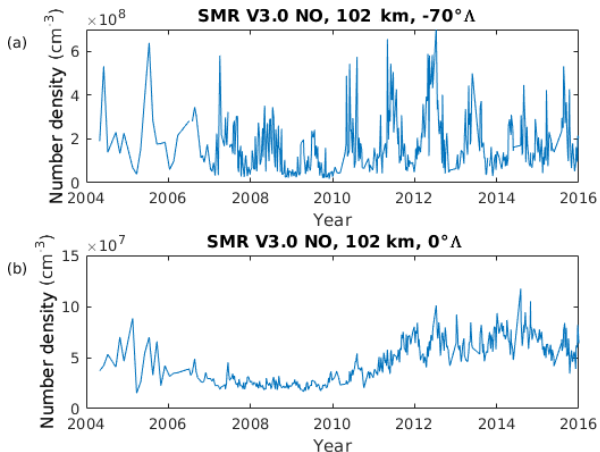
Figure 4. Daily mean NO density of Odin SMR NO at (a) 102km and − 70 ◦ (cid:51) and (b) 102km and 0 ◦ (cid:51) , from 2004 to 2016.